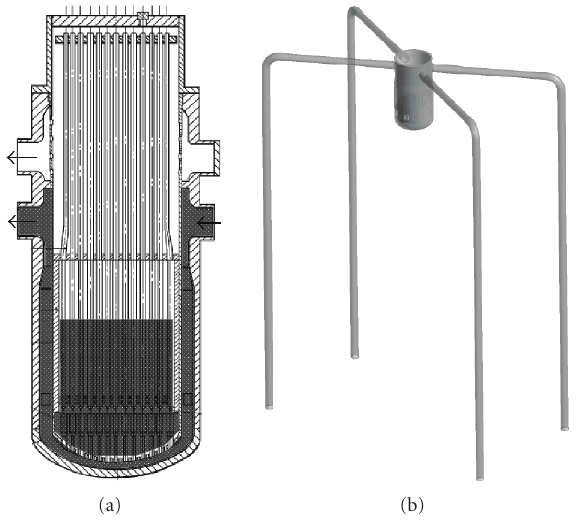
Figure 3: Sketch of the computational domain chosen for CFD